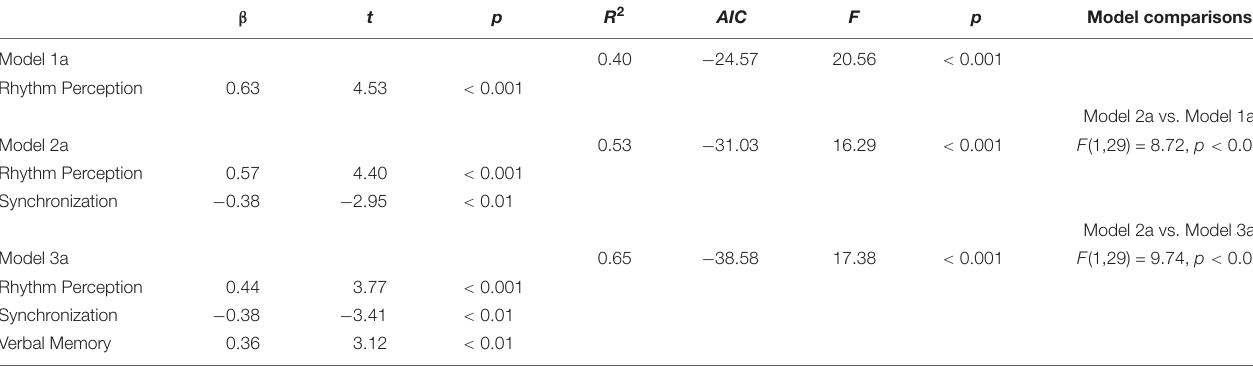
TABLE 5 | Summary and comparisons between Models 1a, 2a, and 3a predicting phonological awareness.